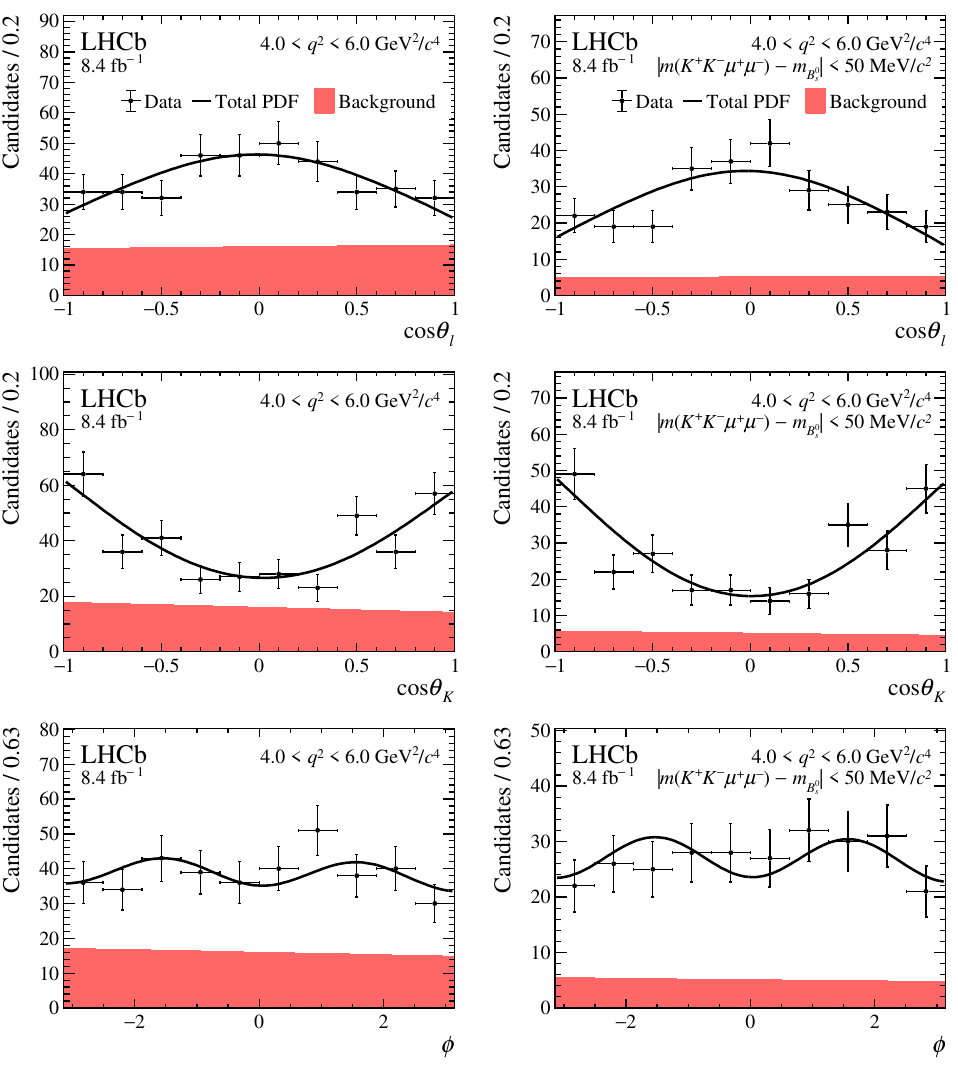
Figure 7 . Projections in the region 4 . 0 < q 2 < 6 . 0 GeV 2 /c 4 for the angular distributions of the the combined PDF. The red shaded area indicates the background component and the solid black line the total PDF. The angular projections are given for candidates in (left) the entire mass region used to determine the observables in this paper and (right) the signal mass window ± 50 MeV/ c 2 around the known B 0 s